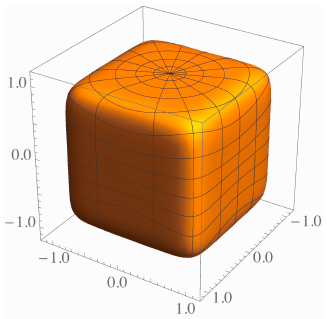
Figure 1. The shape given by Equation (1) for p = 8 and R = 1 .